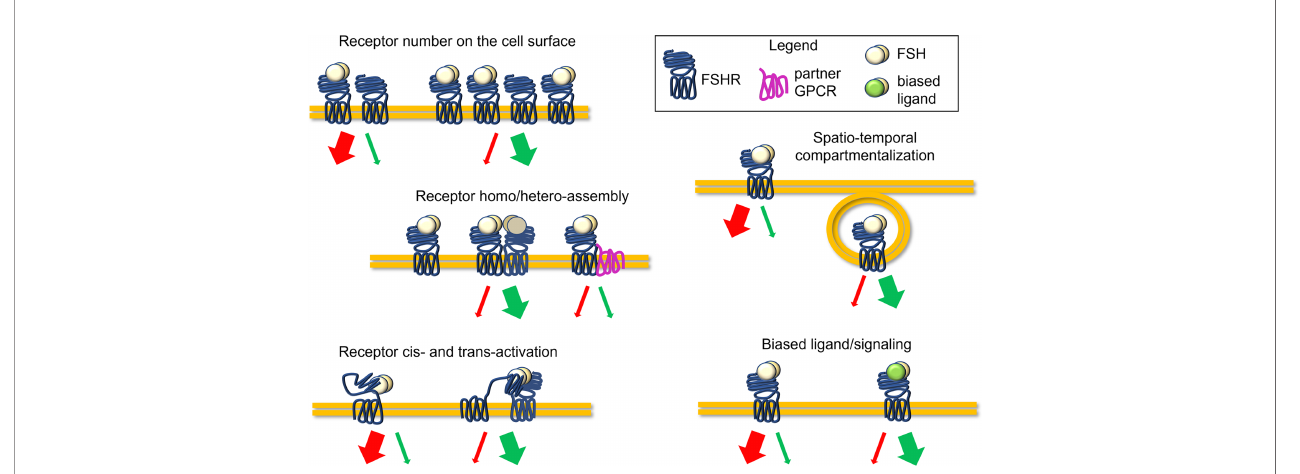
FIGURE 1 | Complexity of the FSHR signaling regulation. Molecules with disrupting activity might potentially interfere with the FSH-induced signaling, impacting FSHR expression levels, receptor conformational assembly and cis/trans-activation, the compartmentalization of ligand-receptor complexes, and biased signaling, acting as allosteric modulators. Finally, disrupting molecules may modulate serum FSH levels or hormone binding to the